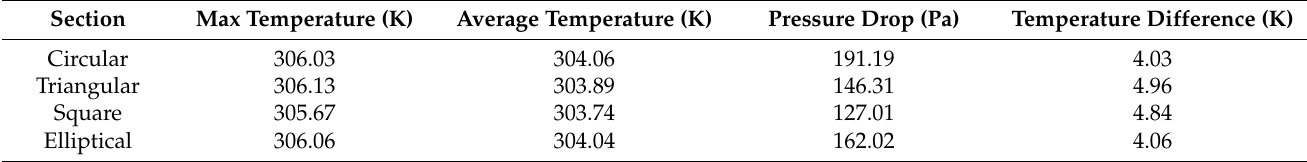
Table 5. Effect of various pin-fin shapes.